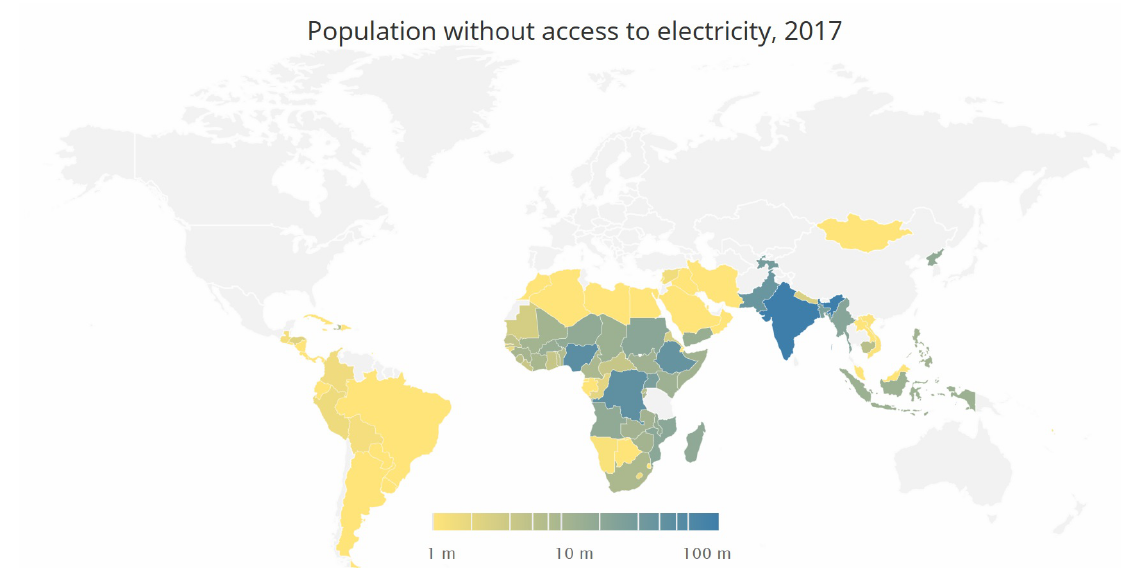
Figure 7. Population without access to electricity, 2017 [12]. Source: Reproduced with permission from IEA (2017) Sustainable Development Goal 7, 2017.